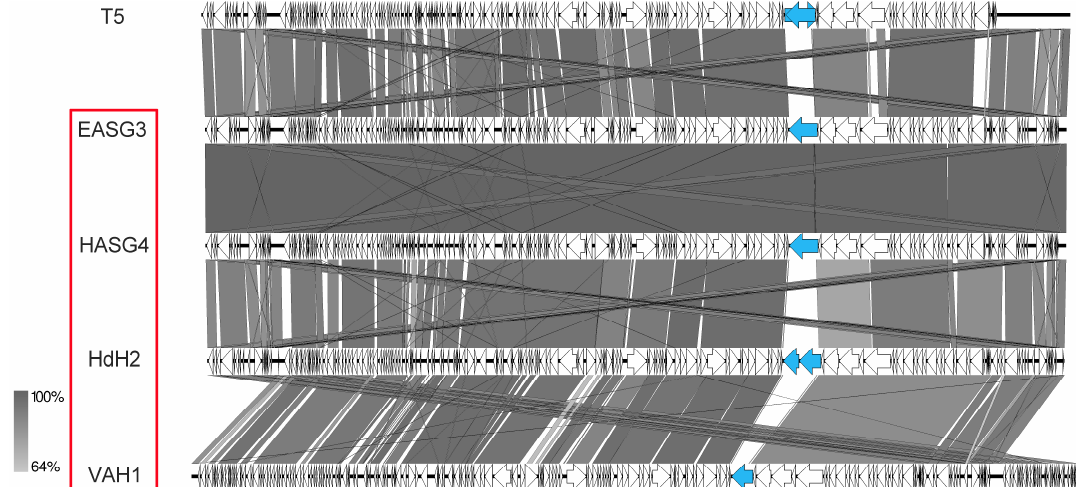
Figure 13. Genomic organization of T5-like phages of this study compared to phage T5 at the nucleotide level. The figure was generated with EasyFig. Isolates of this study are marked in